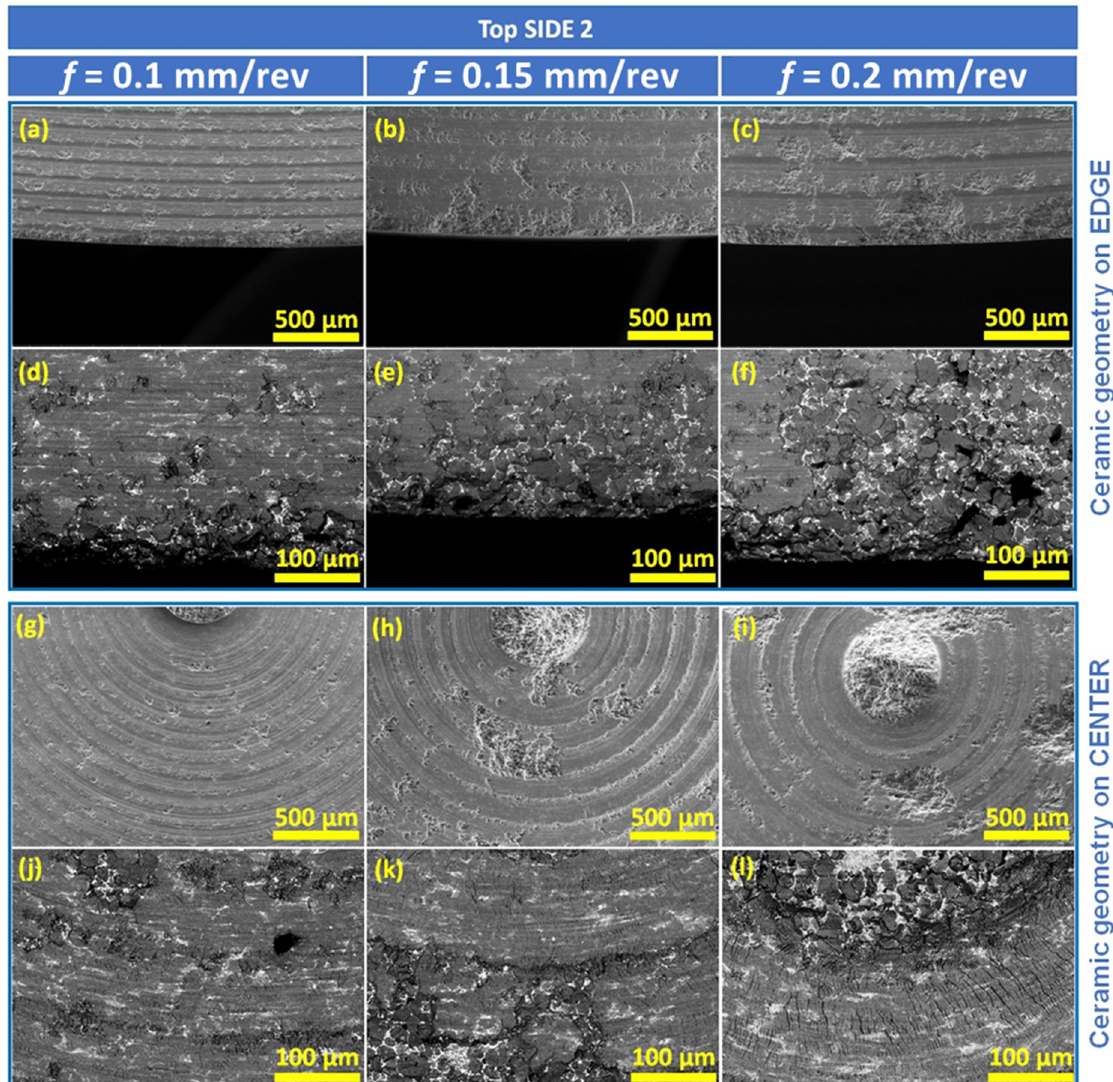
Figure 11. SEM analysis of the static bottom side where the uniaxial pressure was not applied during the green compact processing of ZnO varistors representing the variation in the turning characteristics for different feed rates (horizontally). The SE imaging of the topographical contrast of the surface features after turning at the edges is shown from ( a – c ) for an incremental feed velocity at 100× magnification. The BSE phase contrast imaging at 500× magnification of the edge region is shown by ( d – f ) for a subsequent increase in the feed velocity. The topographical SE imaging at the center of the ZnO varistor is presented for successive surges in feed velocities by ( g – i ), while the phase contrast imaging of the central section of the turned ceramic is illustrated from ( j – l ).